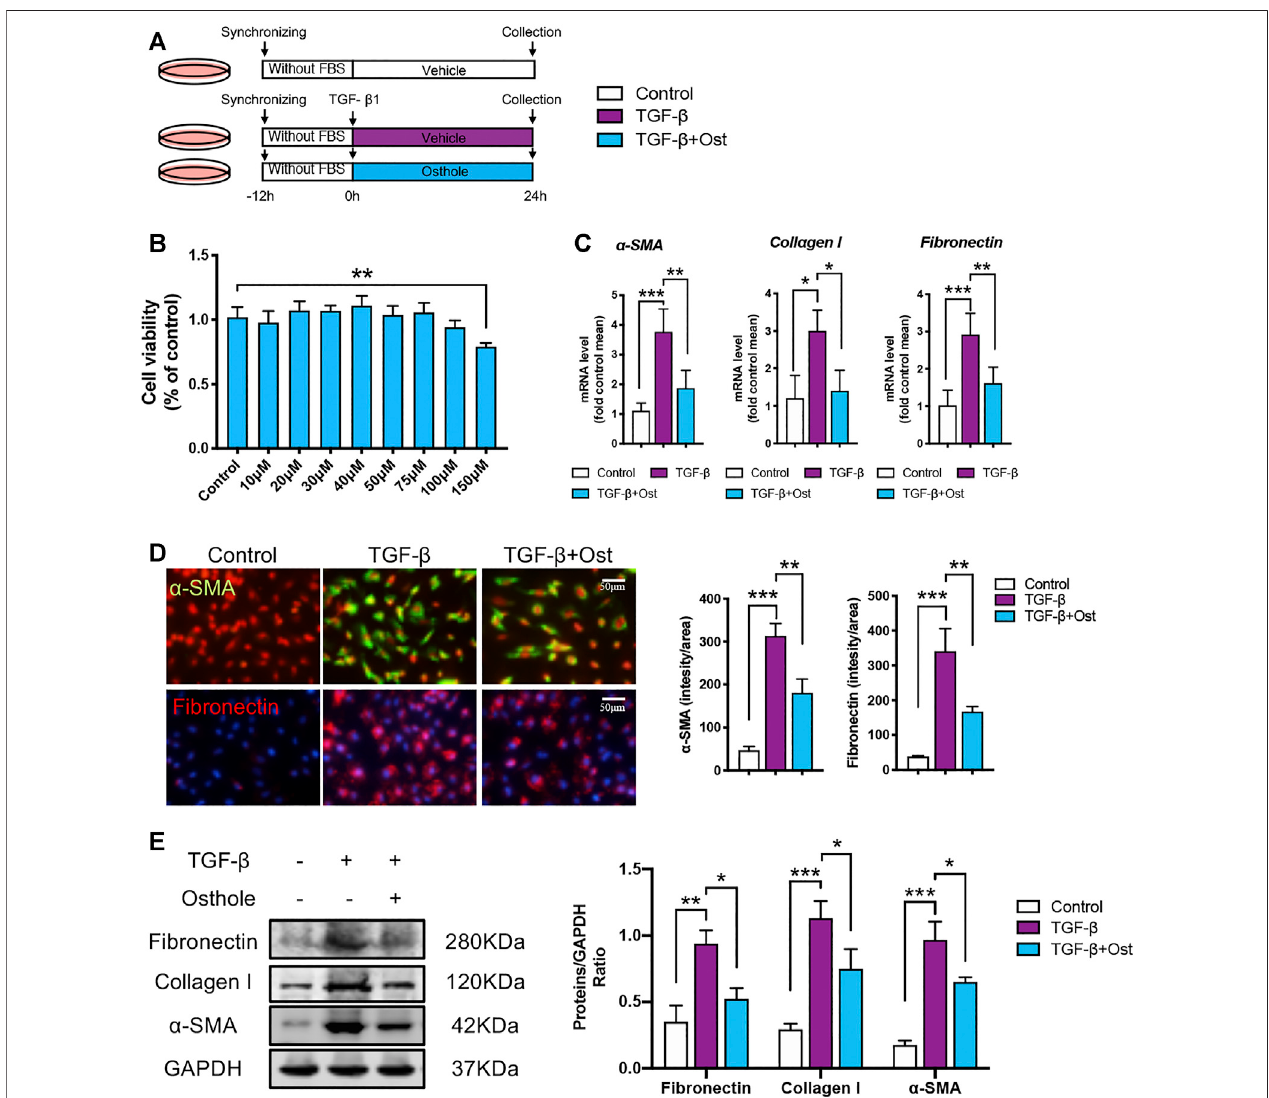
FIGURE 2 | Osthole ameliorates TGF- β -induced HK-2 cells fi brosis in vitro. (A) in vitro experimental protocol of this part. (B) MTT assay was applied to determine theconcentrationsofosthole.( n (cid:1) 4repeats) (C) ThemRNAlevelsof α -SMA,collagenIand fi bronectininHK-2cellsofdifferentgroups.( n (cid:1) 4repeats) (D) Representative immuno fl uorescence stainingfor α -SMA and fi bronectin;the quanti fi cation of α -SMA and fi bronectin immuno fl uorescence staining. Scale bar,50 μ m. ( n (cid:1) 4repeats) (E) Representativewesternblotsfor α -SMA,collagenIand fi bronectinproteinexpressionsinHK-2cells;thequanti fi cationof α -SMA,collagenIand fi bronectinwestern blots. ( n (cid:1) 4 repeats). All data are presented as means ± SD. * p < 0.05, ** p < 0.01, *** p < 0.001.